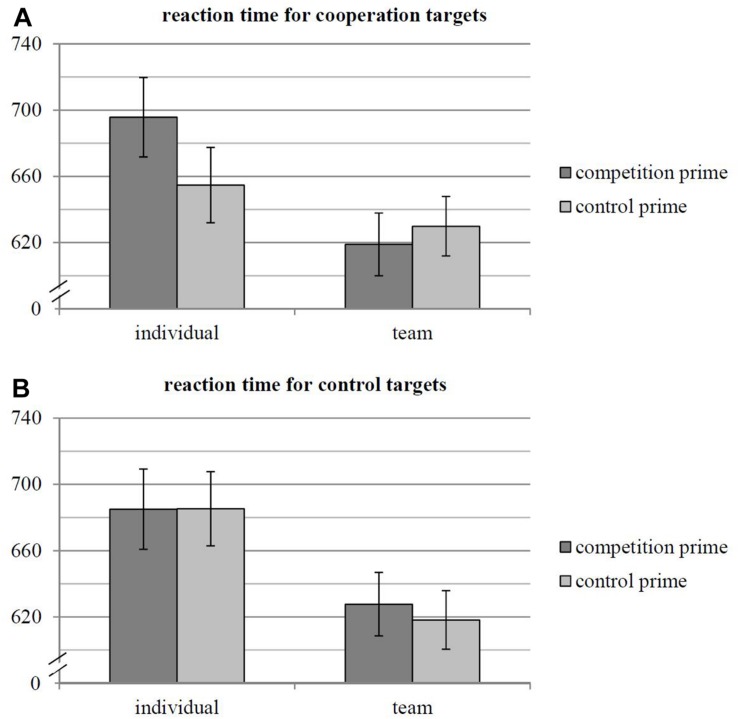
(A,B) Mean reaction times in milliseconds to cooperation targets (A, top) and to control targets (B, bottom) for individual versus team athletes in trials with either competition or control primes (only youth athletes at the OSP, N = 39, two between conditions). Error bars denote one standard error around the mean.